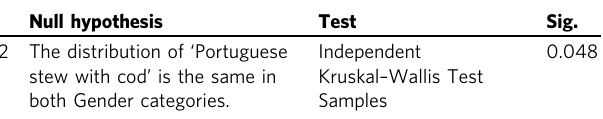
Table 14 Non-parametric Kruskal – Wallis test between genders regarding identity symbols. Test